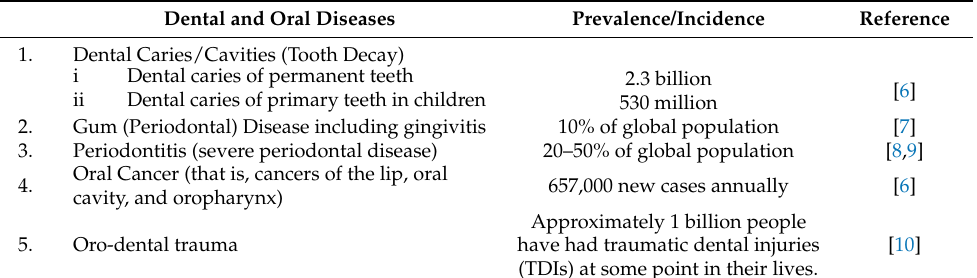
Table 1. The most common oral and dental diseases and the global prevalence of each. Dental and Oral Diseases